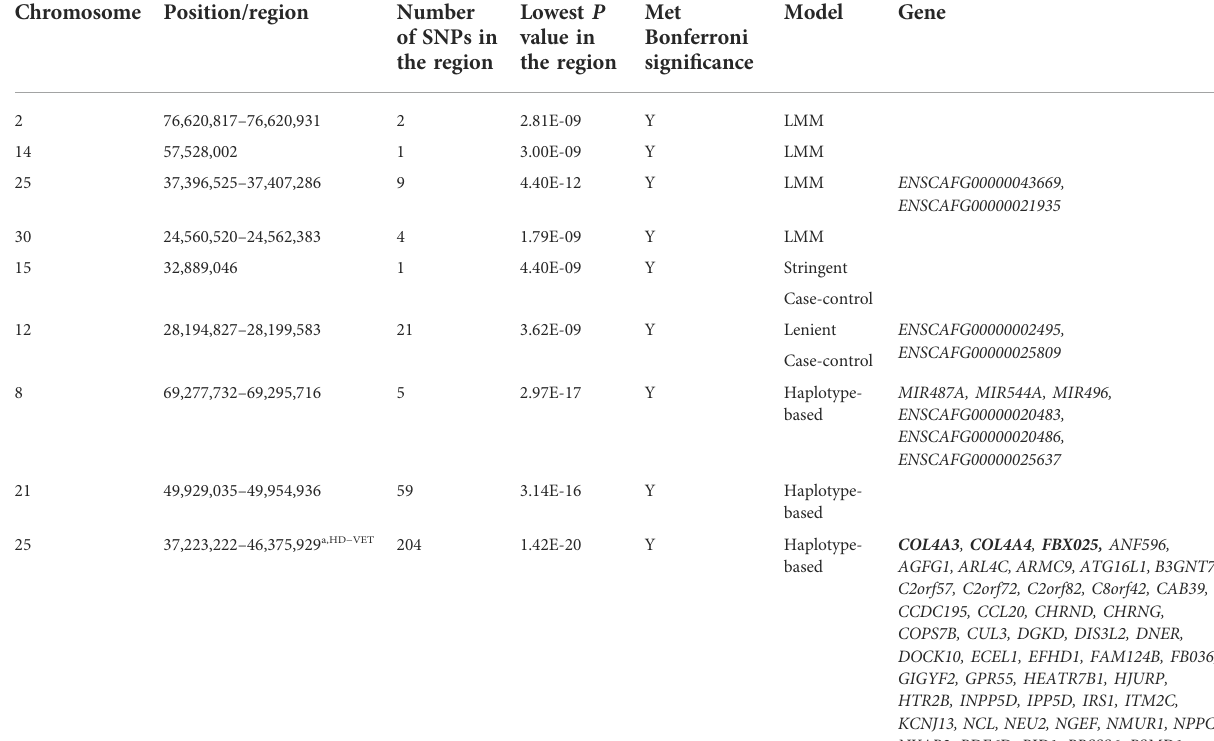
Model Met Lowest P Bonferroni value in of SNPs in signi fi cance the region the region